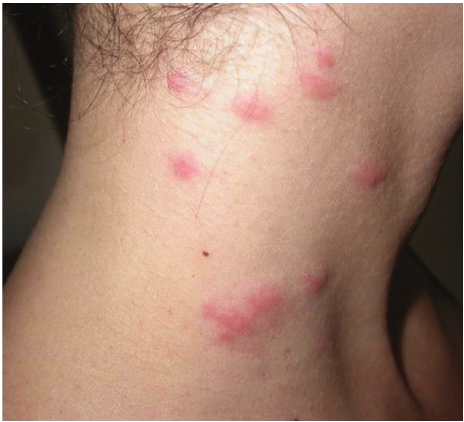
Figure 3: Strophulus-like lesions due to setae of pine caterpillar.